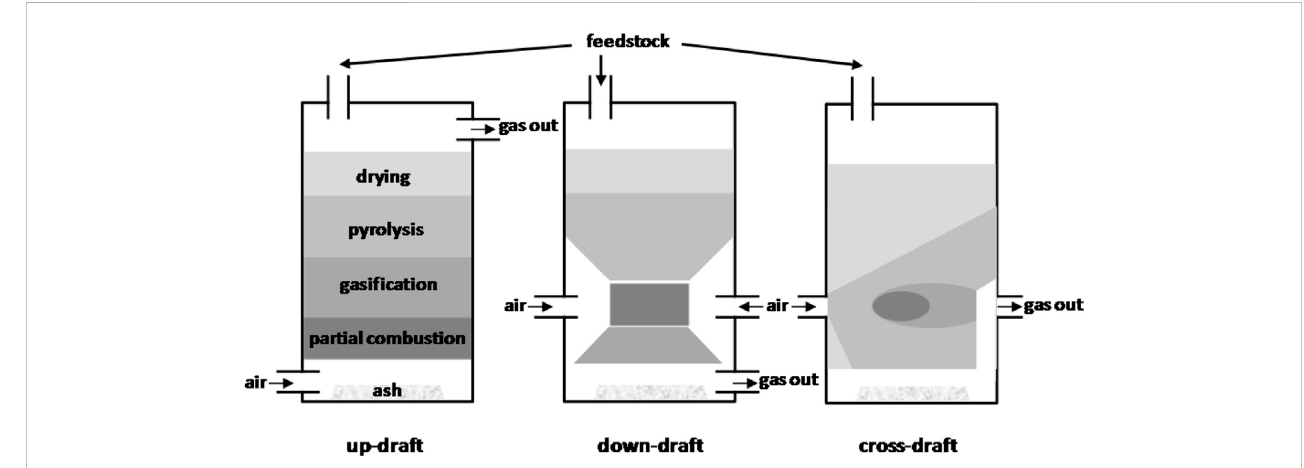
FIGURE 3 Gasi fi cation system types.